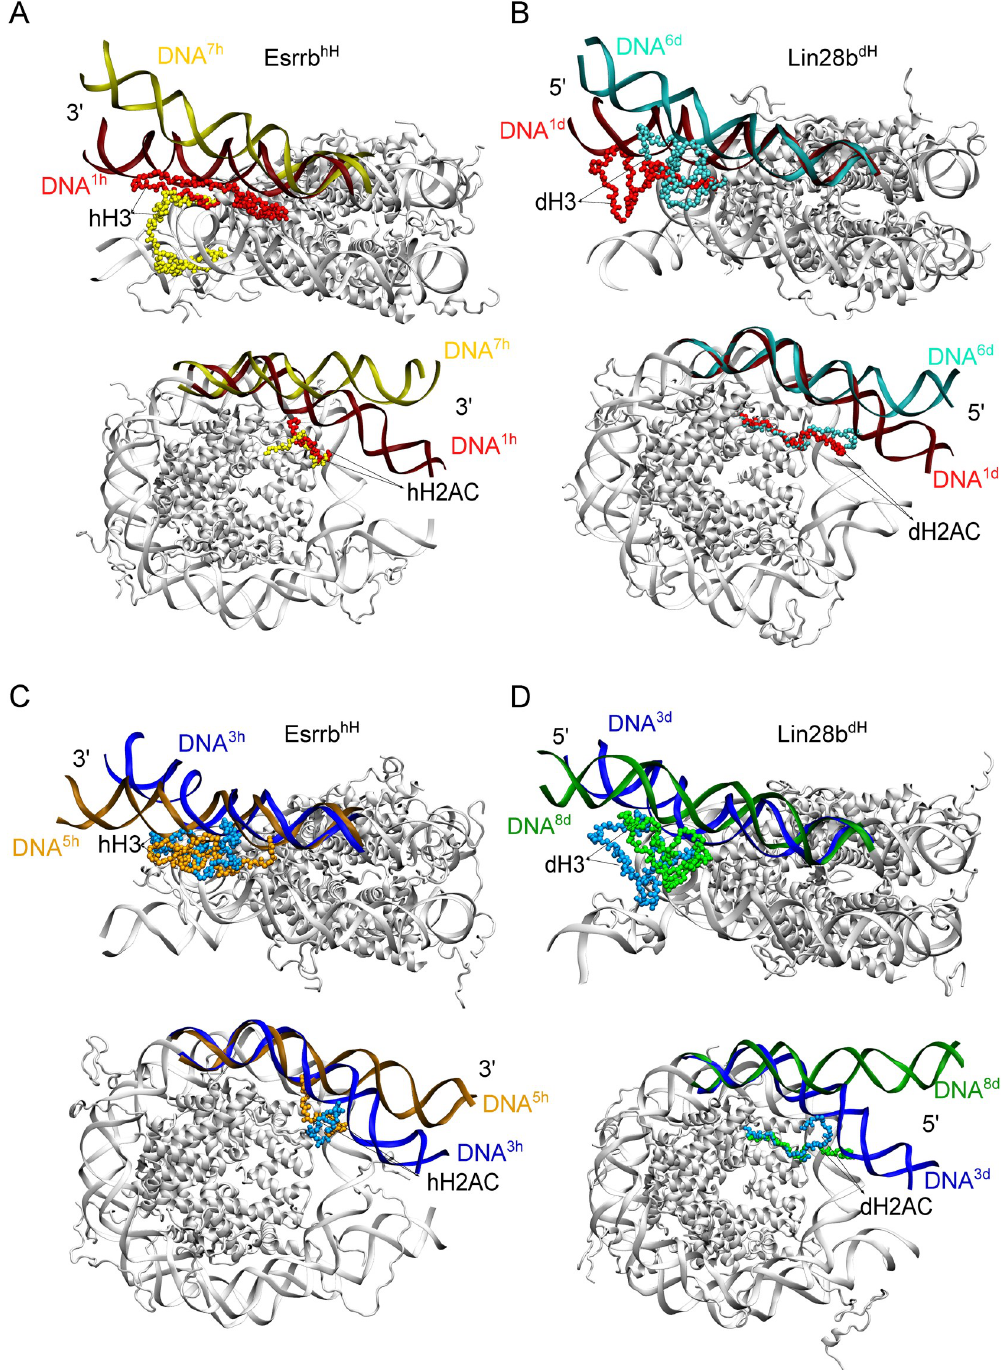
Fig 6. Structures of DNA cluster representatives. The L-DNA used for clustering is colored by the cluster color from Fig 5A and 5B. The L-DNA is in a dark shade, whereas the nearby histone tail is in a lighter shade of the same color. Each panel shows a side view of the nucleosome with the H3 tail (top), and a top view of the nucleosome with the H2AC tail (bottom). (A-B) Conformations closed or open in both the XZ ( γ 1 ) and XY planes ( γ 2 ). For the hH simulations (A), clusters DNA 1 h (closed) and DNA 7 h (open). For the dH simulations (B), clusters DNA 1 d (closed) and DNA 6 d (open). (C-D) Conformations open only in one plane, closed in the other. For the hH simulations (C), clusters DNA 3 h (open in the XY plane) and DNA 5 h (open in the XZ plane). For the dH simulations (D), clusters DNA 3 d (open in the XY plane) and DNA 8 d (open in the XZ plane). For clarity, the 3’ end of the hH nucleosomes is shown in the same direction as the 5’ end of the dH nucleosomes (views are inverted by 180˚ around the dyad axis).